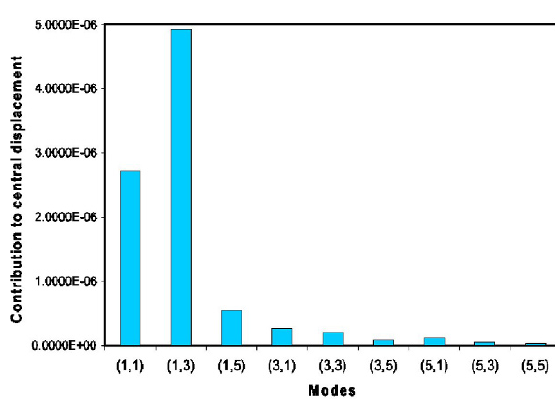
Figure 10. Modal contributions for cylindrical panel subjected to uniform pressure pulse.